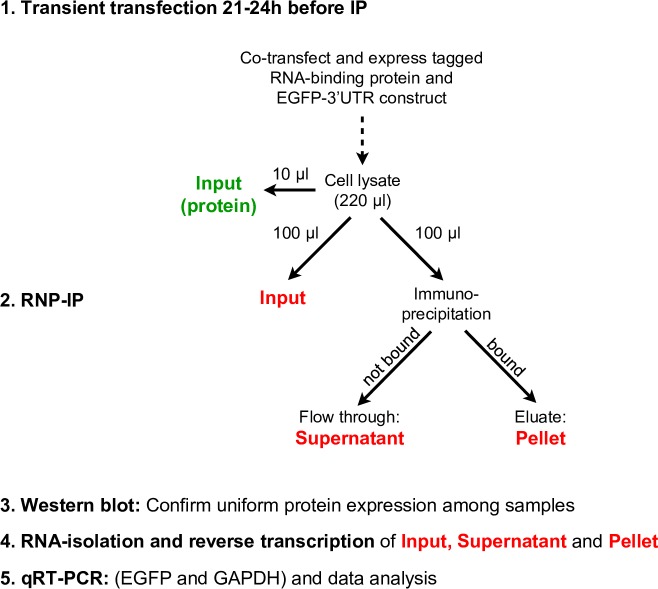
Outline of a co-immunoprecipitation experiment and analysis.Tagged ARE binding proteins as well as an EGFP reporter mRNA containing 3’UTR fragments of interest were transiently co-expressed in HEK 293T cells.